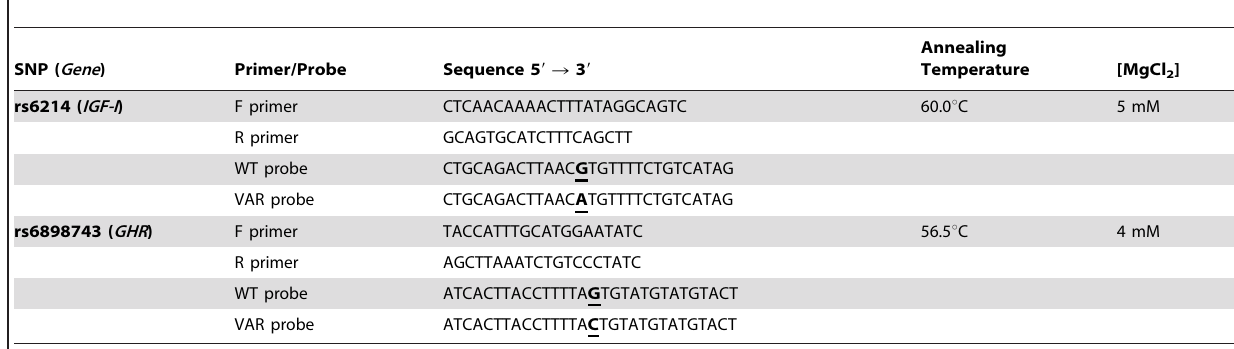
Table 1. Sequences of primers and probes, including the optimal annealing temperature and MgCl 2 -concentration.